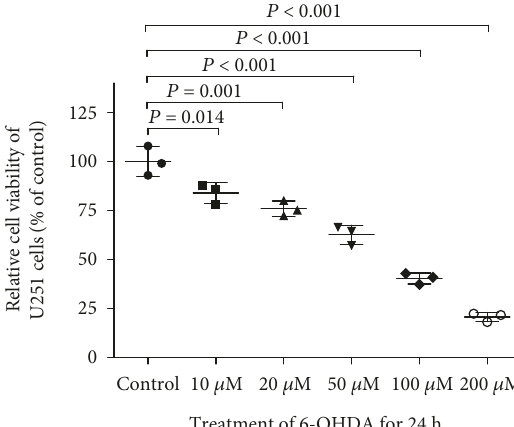
Figure 1: Cytotoxic e ff ect of 6-OHDA on U251 cells. U251 cells were treated with 0-200 μ M 6-OHDA for 24 h, and cell viability was measured by MTT assay and expressed as a percentage of that in the vehicle group. All of the data are presented as the mean ± SD from 3 independent experiments. Di ff erences among groups were examined by using ANOVA followed by Tukey- Kramer tests for post hoc multiple comparisons. F value = 112.6, degrees of freedom between groups (df ) =5, degree of between groups freedom within groups (df ) =12, and the total degree of within groups freedom (df total